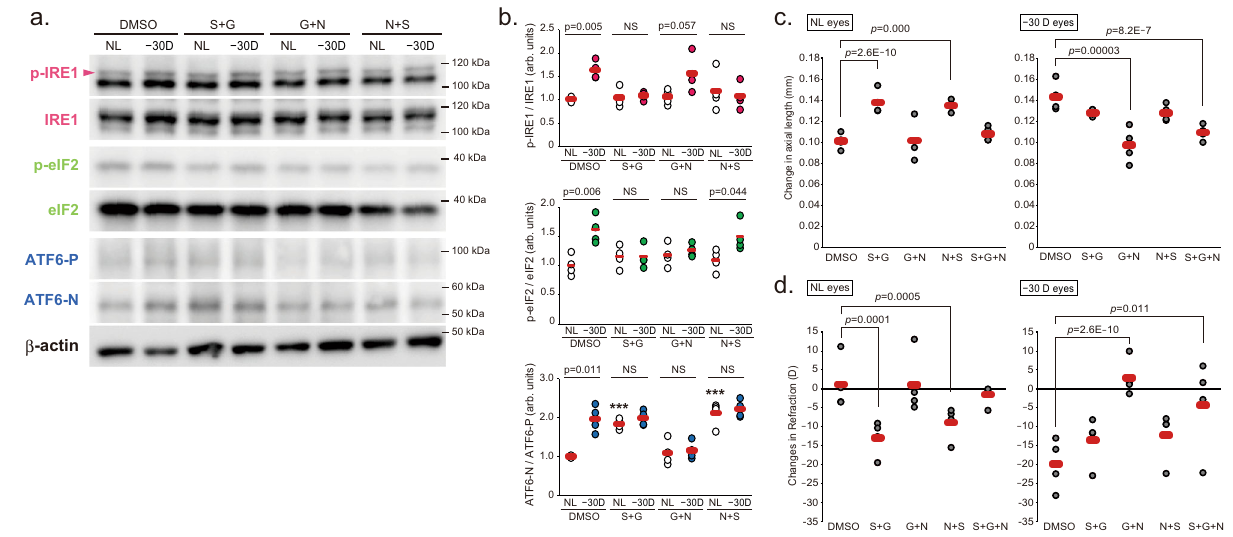
Fig. 5 | Inhibition of both PERK and ATF6 pathways suppresses myopia pro- gression caused by negative lens wearing. a Effects of combined STF, GSK, and NFV instillation (S+G: STF and GSK, G+N: GSK and NFV, N +S: NFV and STF; 100 μ M each) on LIM-induced activation of IRE1, eIF2, and ATF6 in sclerae. NL: No Lenscontrol, − 30D:minus30Dlens-wearingeye. b Densitometricquanti fi cationof blots in Fig. 5a using ImageJ. DMSO-NL group was assigned a value of 1.0. Each group were n =4 (eachsamplepooled3 sclerae). The p values weredeterminedby two-tailedGeneralizedEstimatingEquationsforfourgroupscomparison(DMSOvs